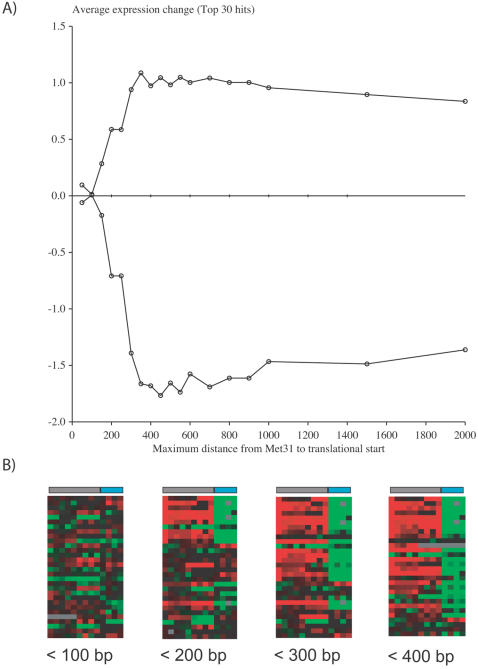
Met4 binding is within 450 bases of the gene start, but not within 100 bases.We varied the allowed distance that the Met31 binding site can be from the gene start point in our models, and quantified how this spacing constraint affected our ability to predict microarray expression data. A) We plotted the average expression change of the top 30 hits in the genome for different maximum spacings from the gene start. The top line corresponds to data from experiments where we expected increased expression (columns 1 to 9 in B), and the lower line is from experiments where we expected decreased expression (columns 10 to 13 in B). The microarray data that corresponds to our gene-ranking are shown in B. The conditions for each column in the microarrays correspond to the labeled columns in Fig. 6.